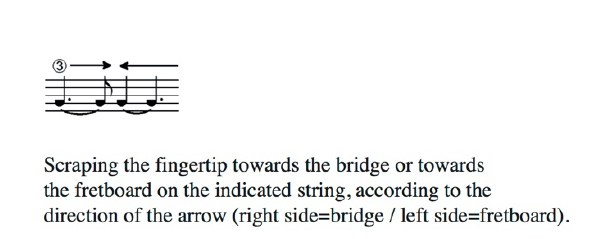
Figure 4. Examples from the performance notes